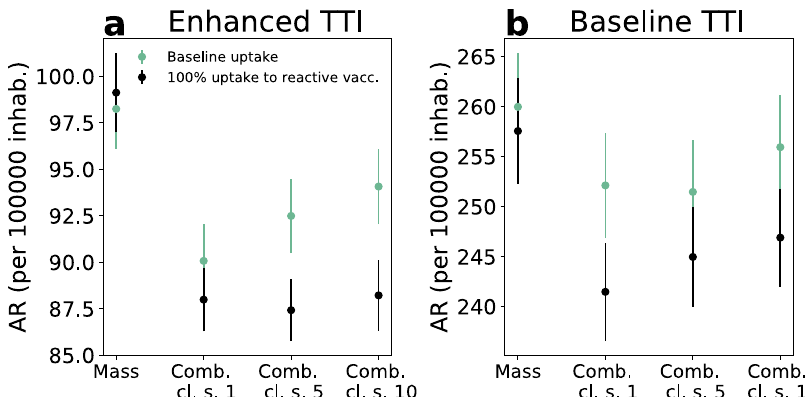
Fig. 4 Combined reactive and mass vaccination for managing a COVID-19 fl are-up. a, b Attack rate (AR) per 100,000 inhabitants in the fi rst 2 months for the enhanced ( a ) and baseline ( b ) TTI scenarios described in the main text. Four vaccination strategies are compared: mass only, combined where the reactive vaccination starts at the detection of 1, 5, 10 cases (Comb. cl. s. = 1, 5, 10 in the Fig.). For mass vaccination the number of fi rst-dose vaccinations during the period is the same as in the comb. cl. s = 1 of the same scenario. Except when otherwise indicated parameters are the ones of the baseline epidemic scenario with intermediate vaccination coverage at the beginning — i.e. R = 1.6; VE S ,1 = 48%, VE SP ,1 = 53%, VE S ,2 = 70%, VE SP ,2 = 73%; initial immunity 32%; vaccinated at the beginning 90% and 40% for 60 + and <60, respectively. In both panels, data are means over 8000 independent stochastic realisations and error bars are the standard error of the mean (±2SEM). Corresponding incidence curves are reported in Supplementary Fig. 9. The following abbreviations were used in the Fig.: vacc. for vaccines, inhab. for